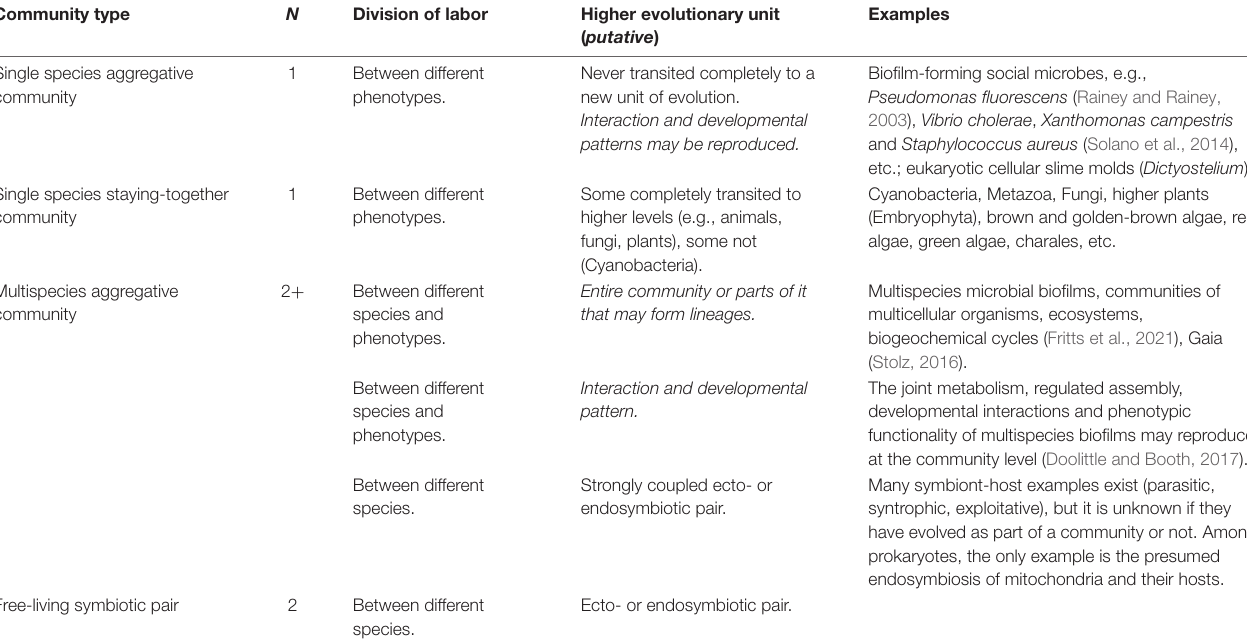
TABLE 1 | Properties and examples of various types of community-forming and transitions in individuality. Community